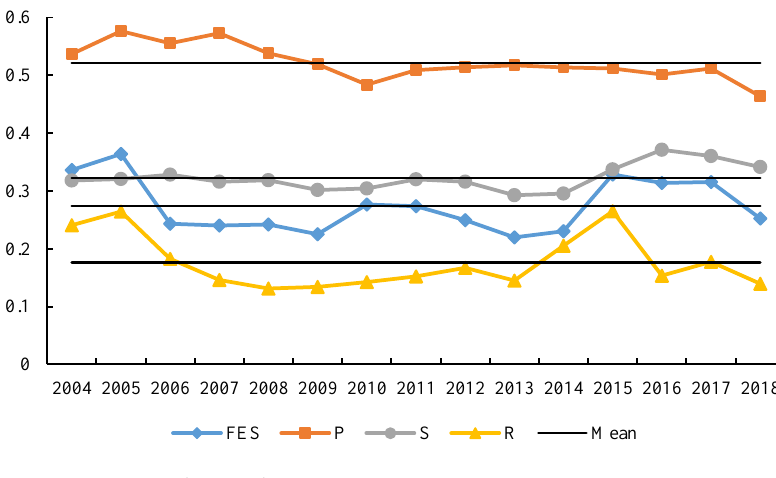
Figure 6. Moran index results.